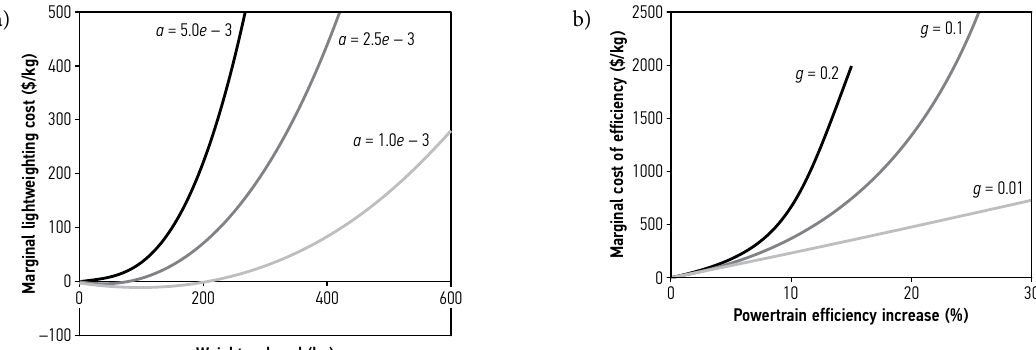
Fig. 10. Sensitivity of exponential lightweighting and powertrain technology cost functions to marginal cost coefficients a and g